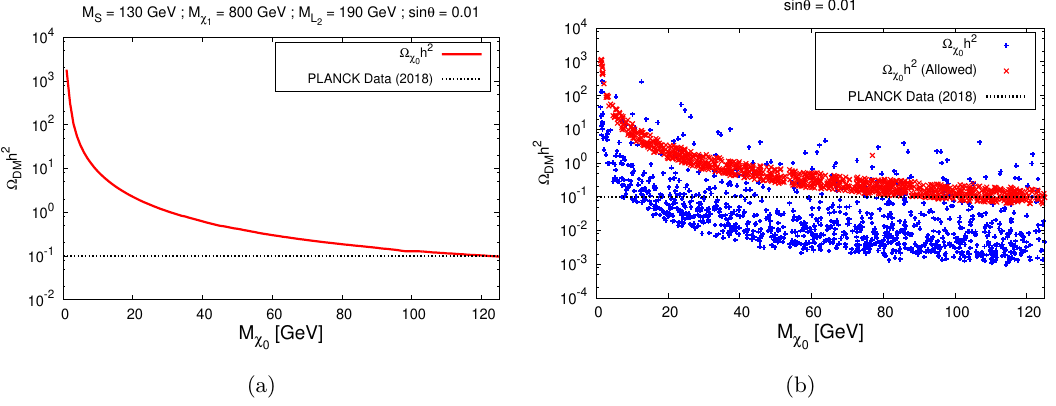
, when M = 300 GeV. (b) η 0